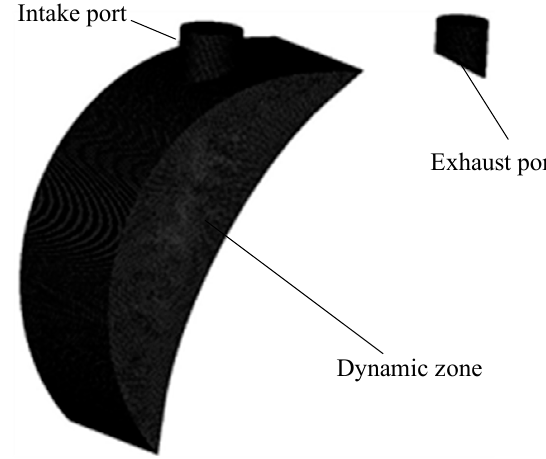
Figure 2. Computation mesh.